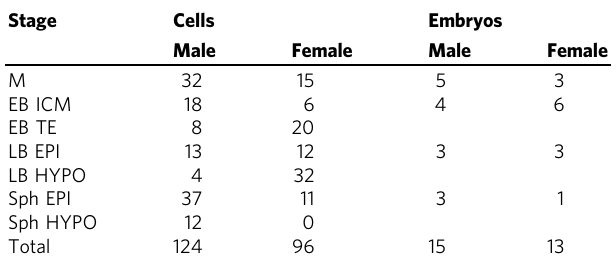
Table 3 Summary of female and male cells